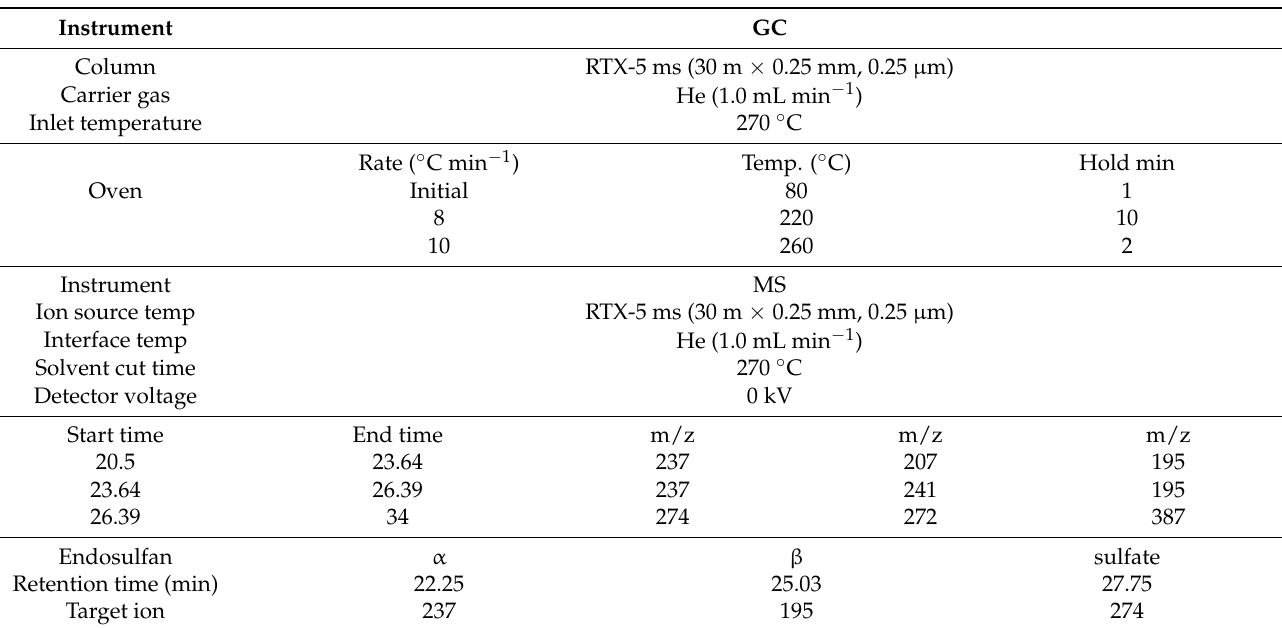
Table 3. Analytical conditions for endosulfan in ginseng (GC-MSD, Shimadzu